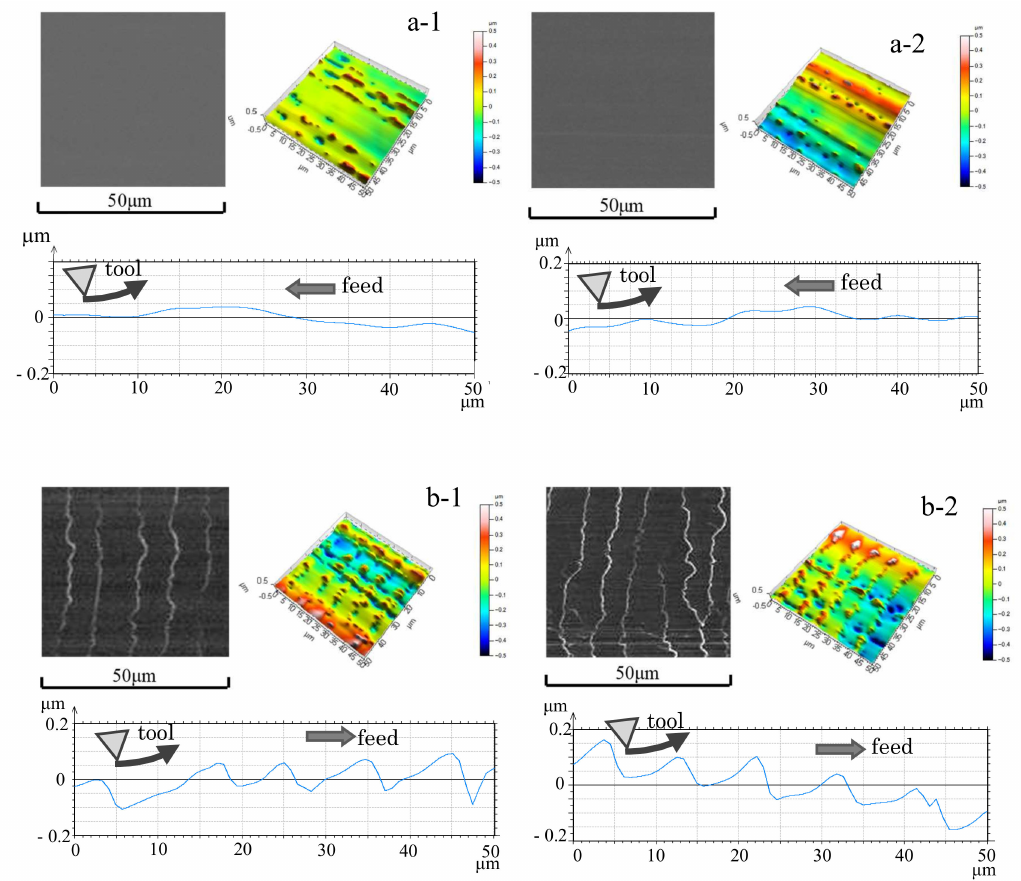
Figure 6. SEM images, 3D images, and profile curves of the machined surface ( a-1 ) Up cut, L = 1.5 m ( a-2 ) Up cut, L = 7.0 m ( b-1 ) Down cut, L = 1.5 m ( b-2 ) Down cut, L = 7.0 m ( N s = 100,000 min − 1 , f = 5 µ m / tooth).